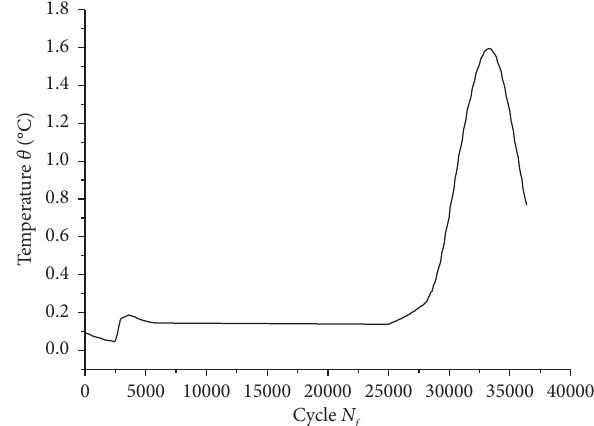
Figure 9: Temperature evolution of composite gels under cyclic